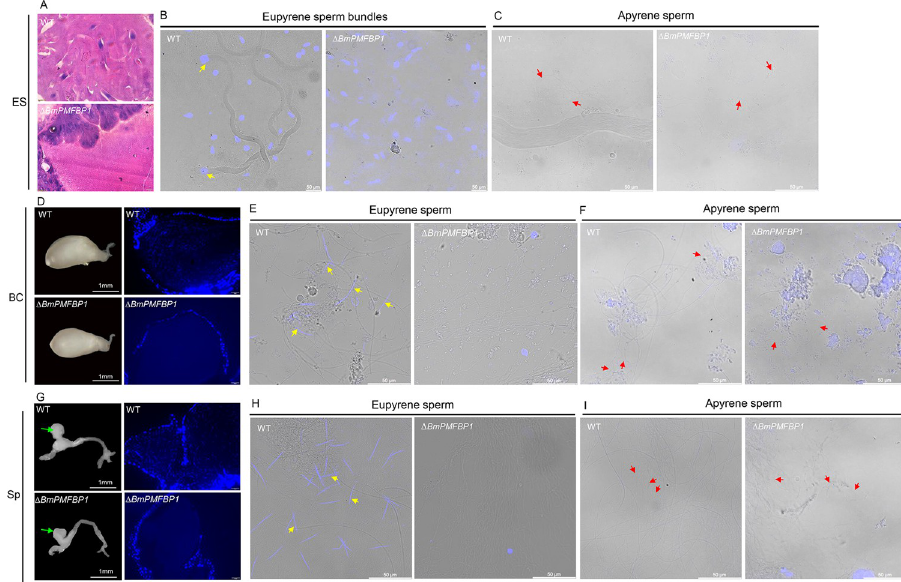
Fig 6. BmPMFBP1 is essential for eupyrene sperm migration to female reproductive tracts. (A) Morphologies of internal structure of ejaculatory seminalis of unmated WT and Δ BmPMFBP1 males. (B, C) The smear of the ejaculatory seminalis (ES). (D) Morphologies and internal structure of bursa copulatrix in females mated with WT and Δ BmPMFBP1 males. (E, F) The smear of the bursa copulatrix (BC) (G) Morphologies and internal structure of spermatheca in females mated with WT and Δ BmPMFBP1 males. The green arrows indicate the spermatheca. (H, I) The smear of the spermatheca (Sp). The yellow arrows indicated the eupyrene sperm/sperm bundles, the red arrows indicated the apyrene sperm. Paraffin-embedded sections were stained with hematoxylin, eosin, and Hoechst 33258.